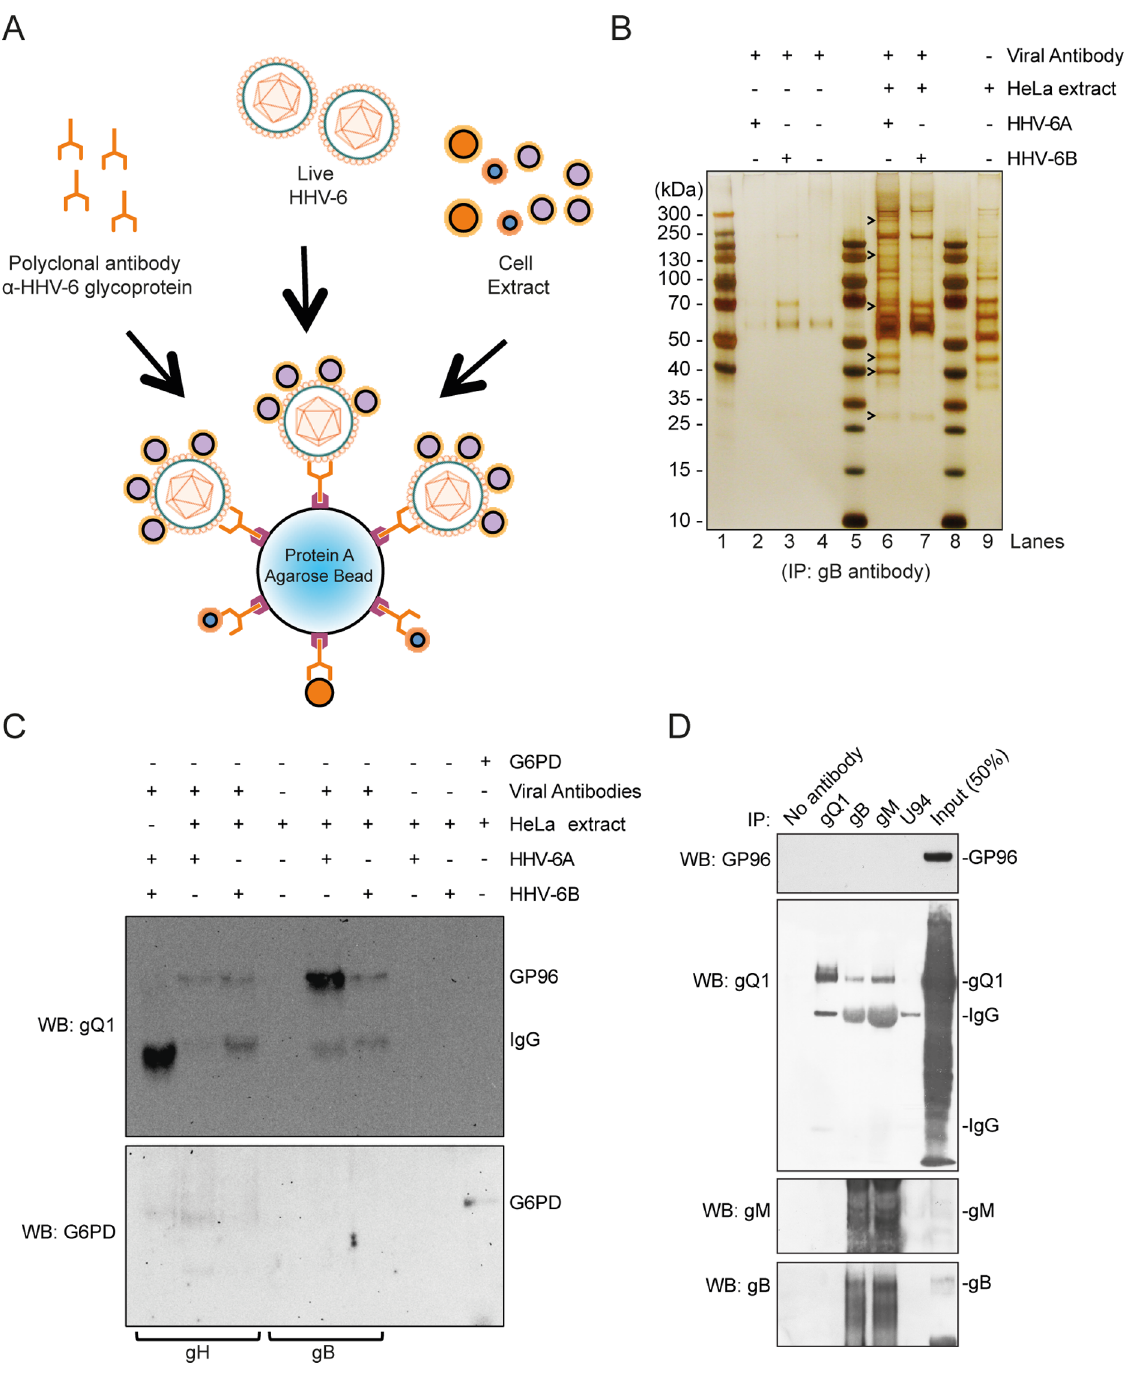
Figure 1. Identification of HHV-6-interacting host cell proteins. ( A ) Diagrammatic representation of immunoprecipitation (IP) experiment to detect unknown HHV-6-interacting host cell proteins. ( B ) Protein complexes directly interacting with HHV-6 viral particles were isolated by IP using anti-HHV-6 gB antibody, separated by SDS-PAGE and visualized by silver staining. Molecular weight markers are indicated on the left. Arrowheads point to some of the proteins differentially identified by mass spectrometry. Lane 1, 5 and 8 shows pre-stained protein ladders. ( C ) IP and Western blotting were carried out to validate and characterize the interaction between GP96 and HHV-6 envelope glycoproteins. As negative control no antibody (Ab), no HHV-6, no HeLa lysate were used for IP. An antibody against human Glucose-6-P dehydrogenase (G6PD) in the absence of viral particles was also used as a control. The Western